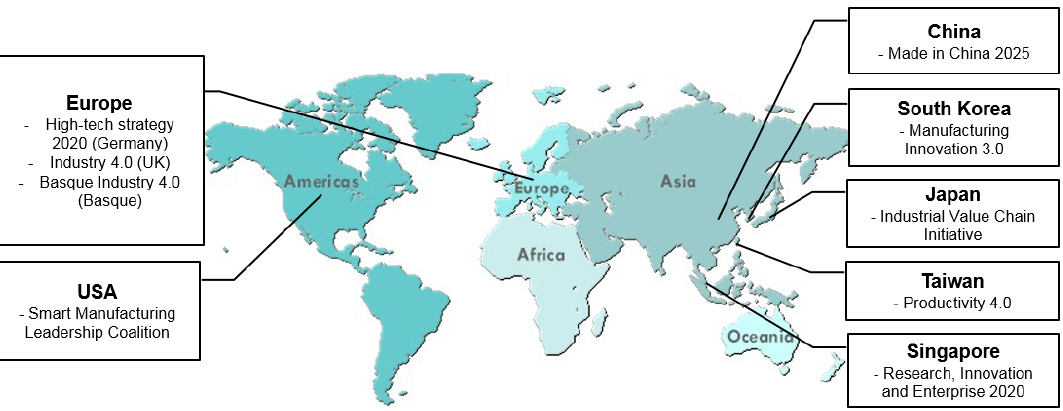
Figure 4. Worldwide initiatives toward i4.